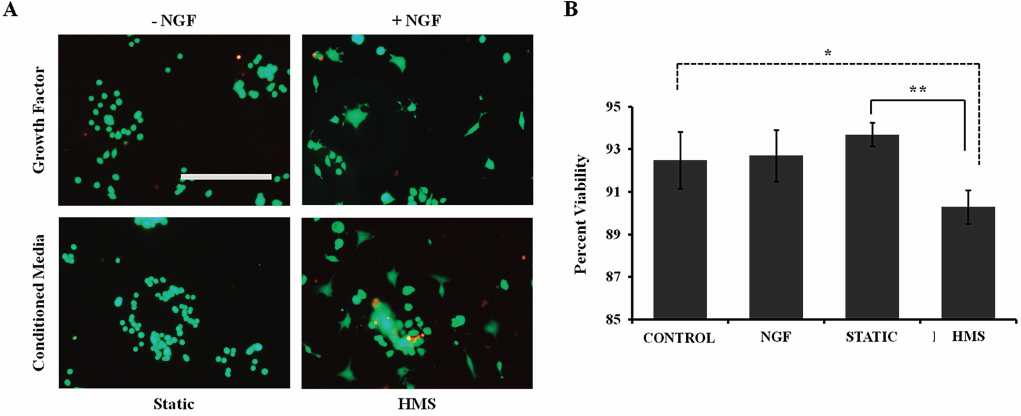
Figure 5. Conditioned media from HMS-cultured chondrocytes causes increased PC12 cell death. ( A ) Representative Live/Dead images showing conditioned media from static and HMS cultured chondrocytes applied to PC12 cells; viability was assessed and compared to vehicle ( − NGF) and NGF treated controls. Green cells (Calcein AM) represent live cells, and red cells (Ethidium homodimer) indicate dead cells. Scale bar: 200 μ m; ( B ) Quantification of viability. Error bars: ±SEM, n = 6, Student’s t -test. * indicates p < 0.05; ** indicates p < 0.01. All samples were compared to − NGF